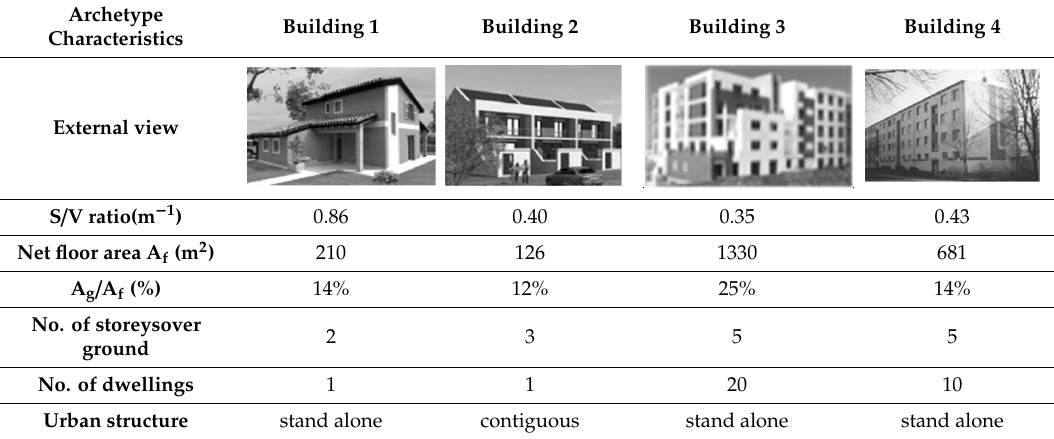
Table 2. General information for the investigated residential buildings. Archetype